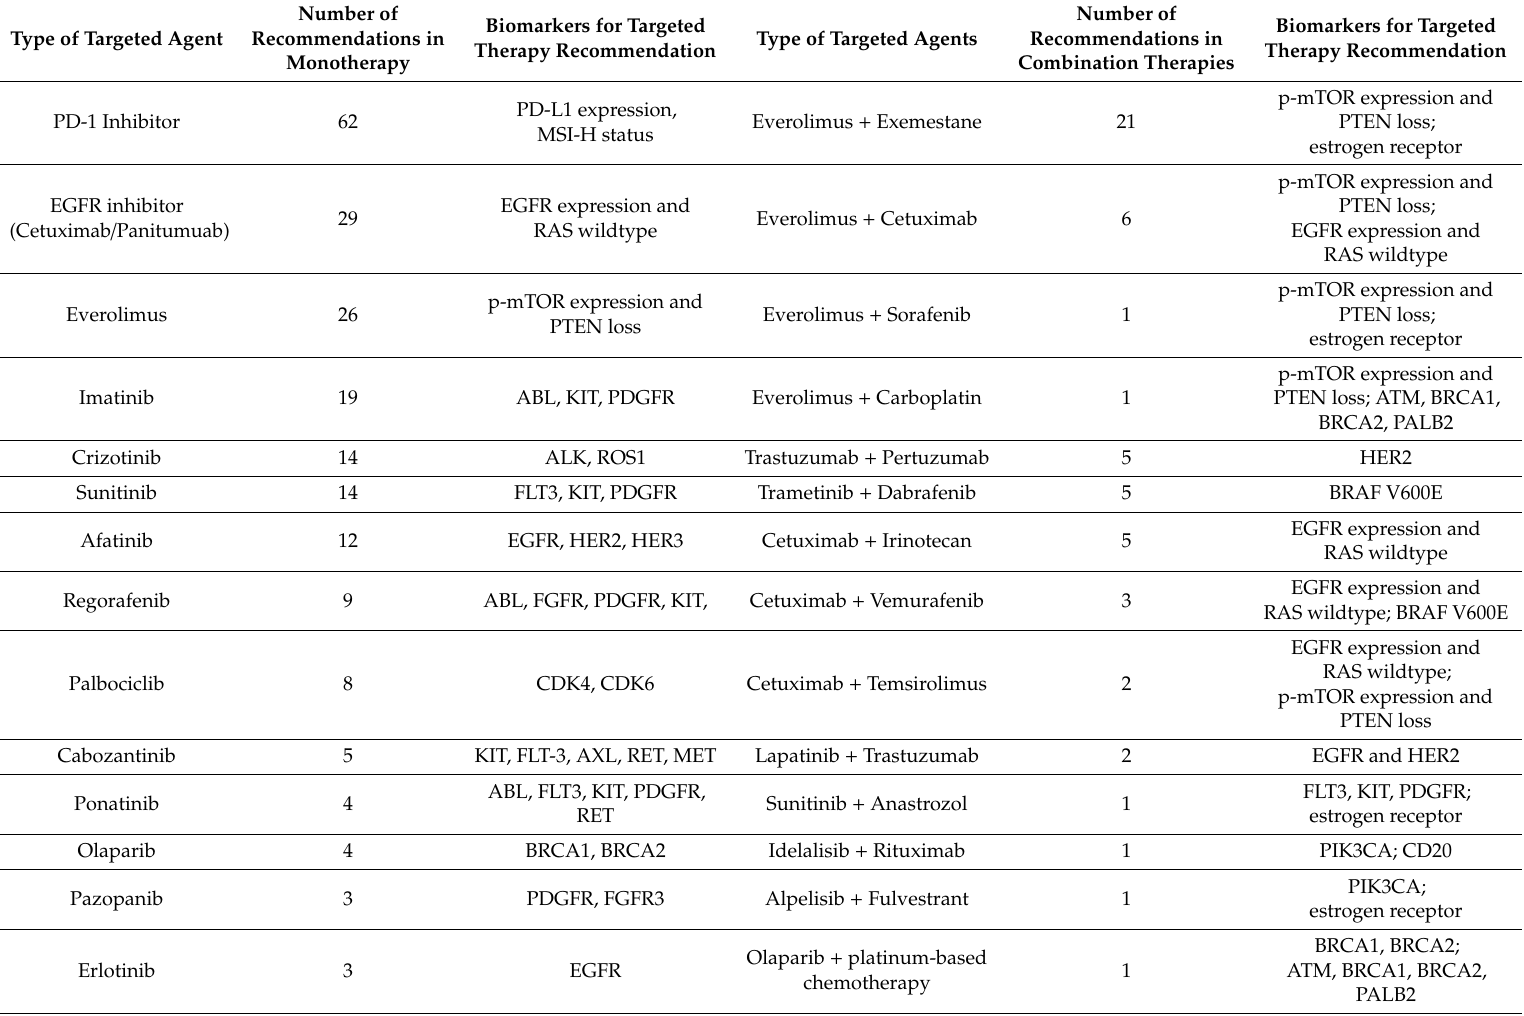
Table 5. Recommended agents in monotherapy and in combination